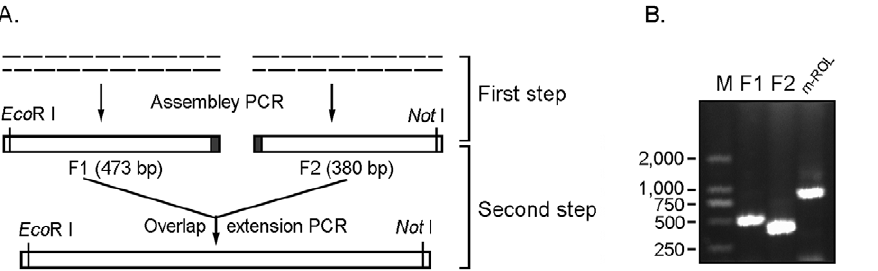
Figure 4. Schema of the two-step ROL gene synthesis method. Full length ROL gene was firstly divided into two overlapped fragments, F1 (473 bp) and F2 (380), and were assembled by assembly PCR separately; Then F1 and F2 was assembled into full length ROL gene by overlap extension PCR (A). (B) PCR products of F1, F2 and full-length ROL gene.